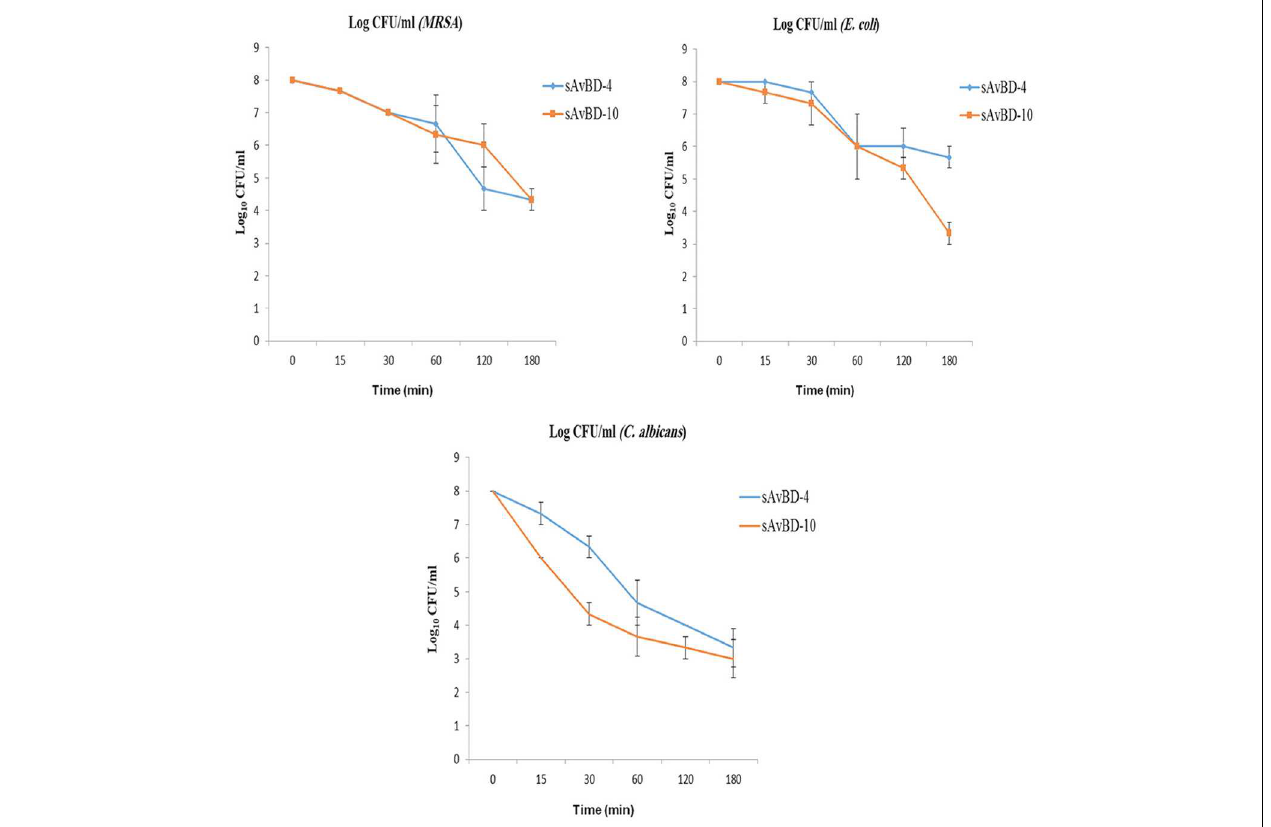
FIGURE 2 | The kinetic inactivation of synthetic chicken β -defensin-4 and 10-derived peptide (sAvBD) against MRSA, E. coli and C. albicans species. All assays were performed in three independent experiments and each point is the mean ±